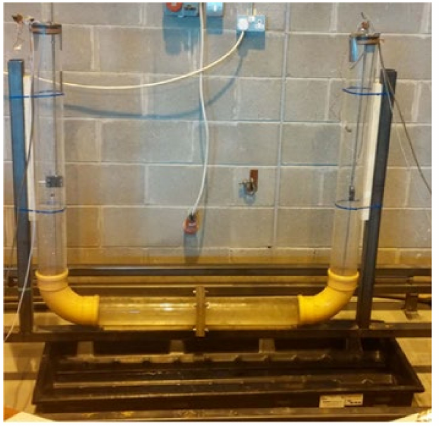
Figure 19. Tuned liquid column damper (TLCD) used in the test of buildings